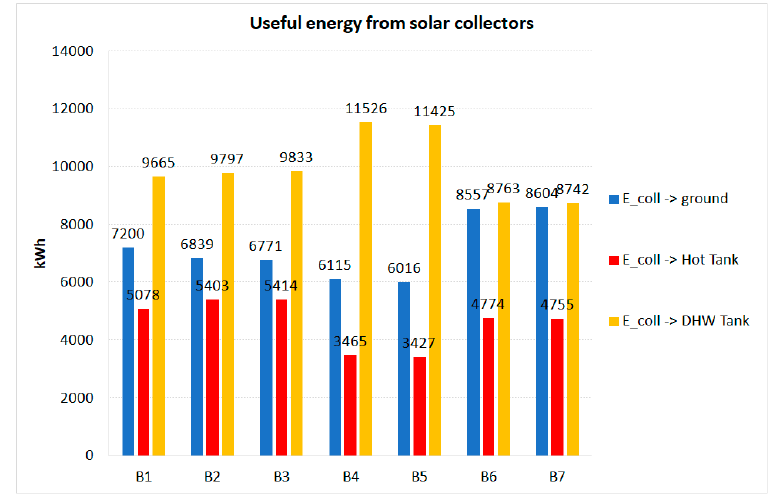
Figure 19. Useful solar radiation from thermal collectors to ground, hot tank and DHW tank.